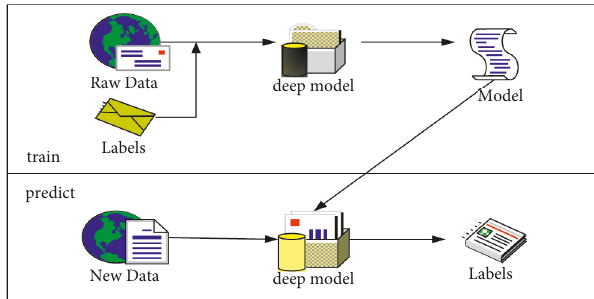
Figure 5: Flowchart of deep learning problem solving.